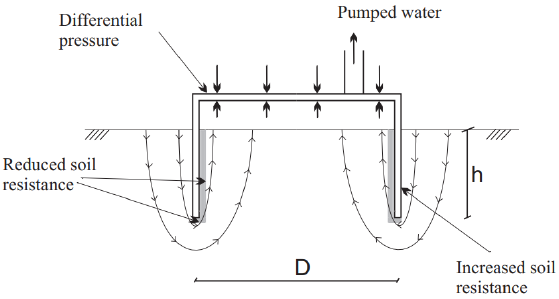
Figure 2. Seepage around the skirt during suction installation in sand